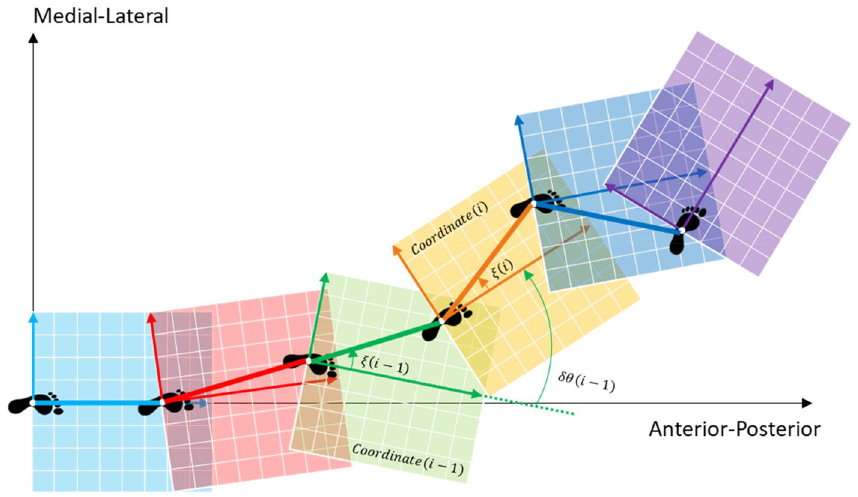
Figure 11. Relationship between adjacent local stepwise gait